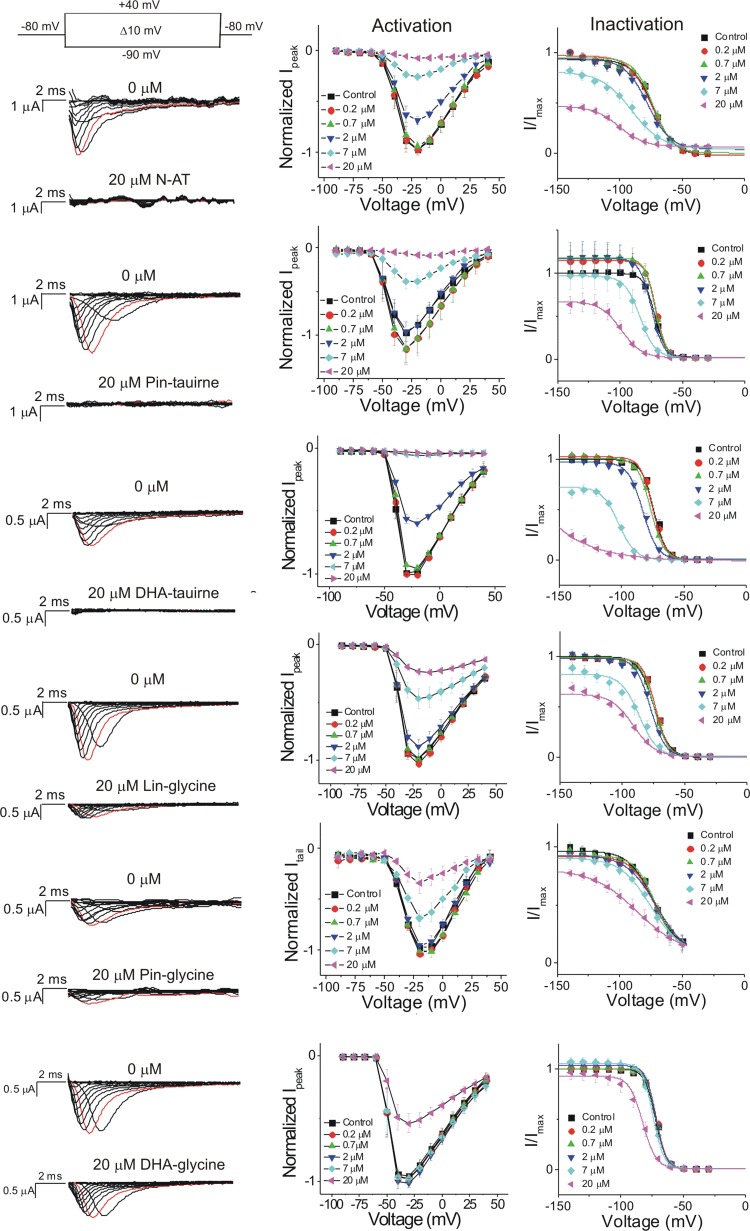
Raw current traces for PUFA analogues on Nav1.5/β1 channels.Nav1.5/β1 raw current traces in control (0 μM) (top trace for each PUFA analogue) and 20 μM (bottom trace for each PUFA analogue) of applied PUFA analogues, followed by current-voltage (I–V) relationship for voltage dependent activation (middle) and I-V relationship for voltage dependent inactivation (right) for each PUFA analogue tested. Voltage protocol (top) overlaps with current traces to illustrate time points during the voltage steps. Red traces represent the voltage step that elicits peak current.